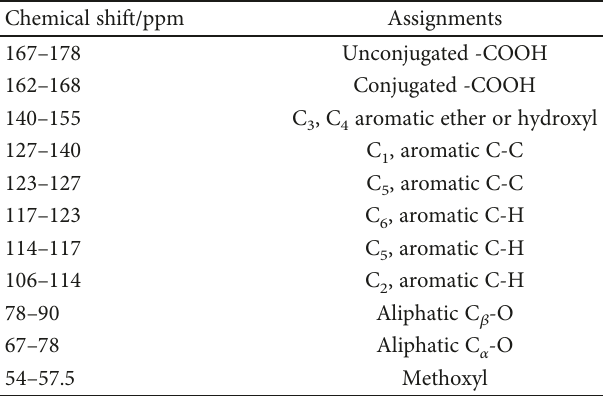
Table 4: Assignments of signals in 13 C NMR spectrum to functional groups in lignin [31, 38, 49,